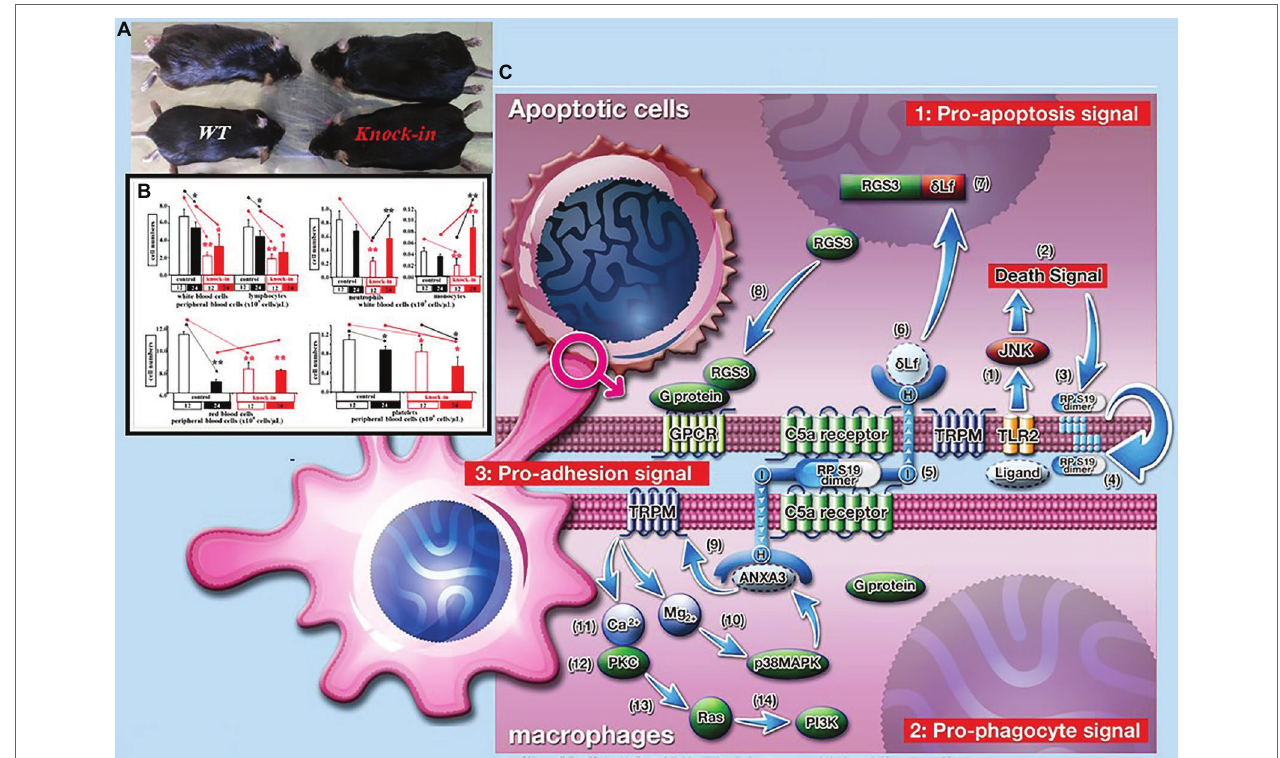
FIGURE 3 | Roles of ribosomal protein S19 polymer in phagocytic clearance of apoptotic cells. (A) In contrast of weight of control C57BL/6J (WT) mice, that of RP S19 mutant gene knock-in (KI) mice at 24-week-olds. (B) In contrast of peripheral white blood cell numbers of WT mice, those of KI mice at 12-week-olds were about one to third times. At 24-week-olds, the decrement of cell number was recovered. Oppositely, peripheral red blood cell numbers were not recovered. (C) RP S19 polymer released from apoptotic cells arises pro-apoptosis, pro-adhesion, and pro-phagocyte signals via